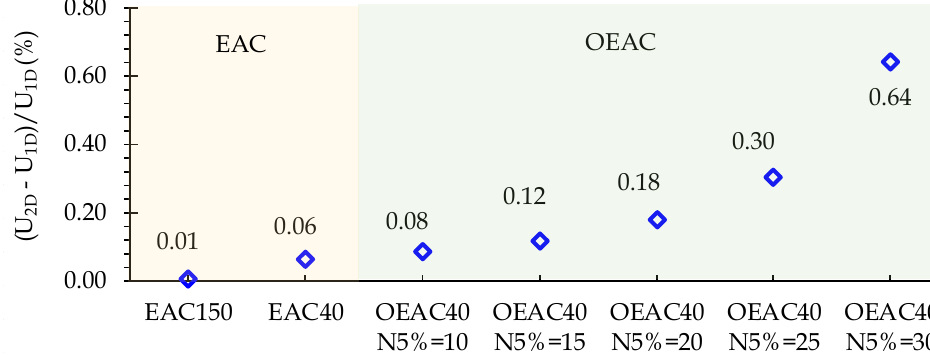
pipe core. Additionally, the OEAC meshes have a discontinuity between the high and the (Figure 11b; see black and green curves for r = 9.5 mm). This discontinuity occurs in the